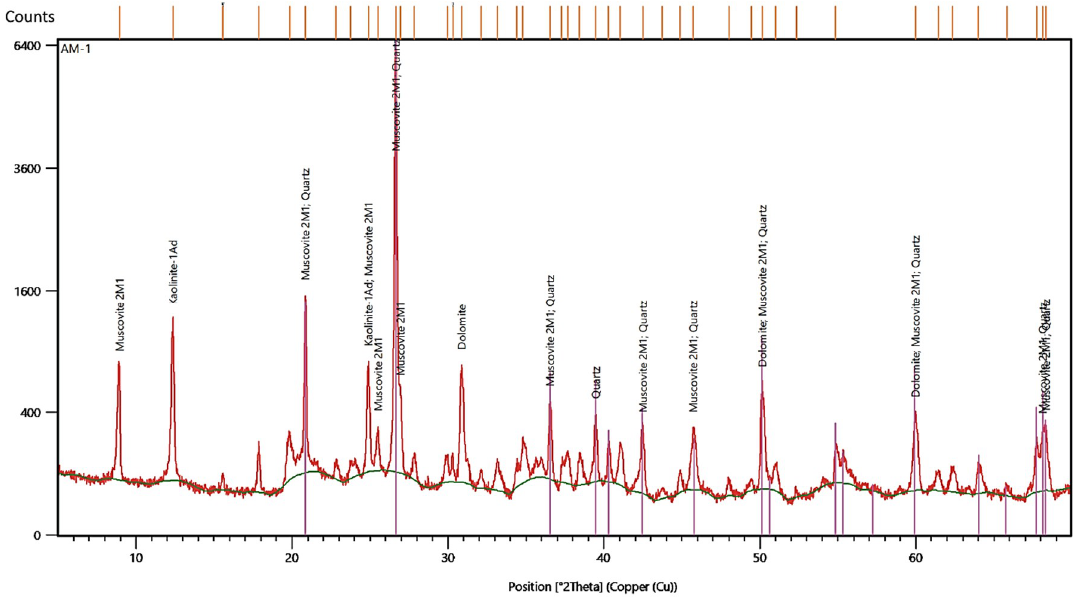
Figure A1. XRD diagram of sample Am 1 (reddish cataclasite).